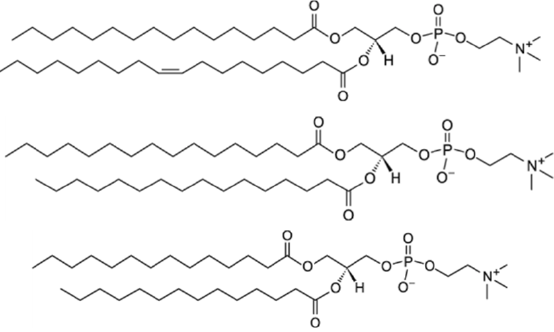
Figure 1. Structures of phospholipids: POPC ( top ), DPPC ( center ), and DMPC ( bottom ).